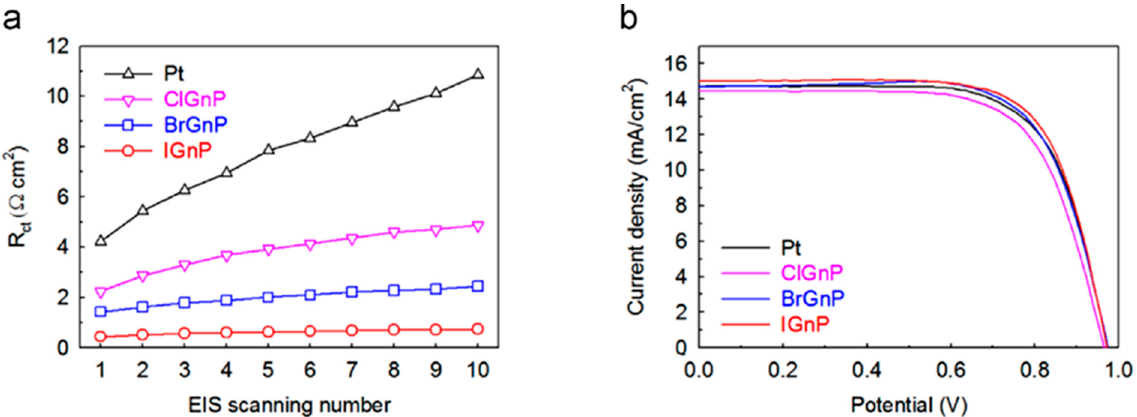
Figure 19. ( a ) Variations in the R ct of Pt and XGnPs-CEs as a function of the EIS scan number. ( b ) J–V curves of CIGnP, BrGnP, IGnP, and Pt-CE-based DSSCs. Reprinted with permission from Reference